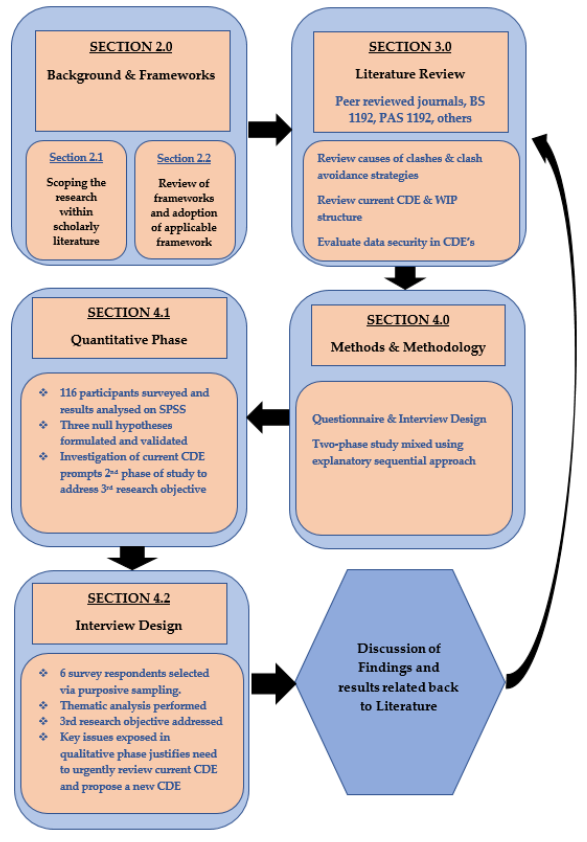
Figure 3. Methodology Roadmap for the study.